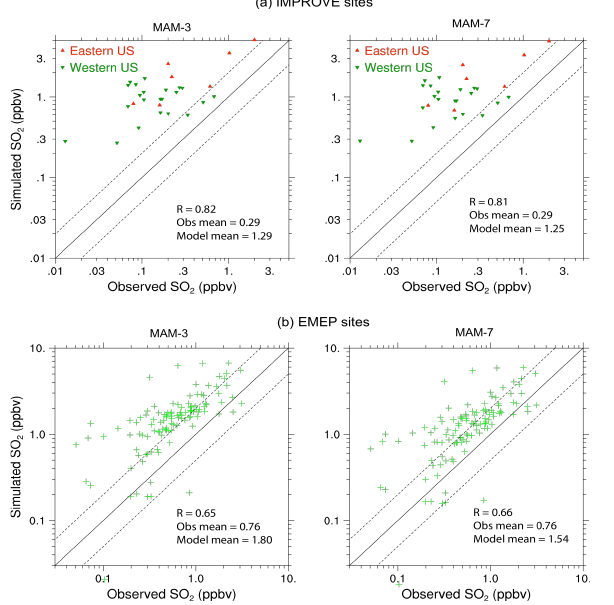
Figure 9. Observed and simulated annual-average sulfate (SO 4 ) concentrations at IMPROVE and EMEP network sites. Observations are for site-available years between 1995-2005. Simulated values for MAM3 (left) and MAM7 (right) are from model lowest layer. Top: IMPROVE network, Eastern U.S. sites are east of 97 W longitude. Bottom: EMEP network. EMEP plots show total and non-sea salt (nss) SO 4 , and IMPROVE plots show total SO 4 . The CAM5 SO 4 species are nss-SO 4 , and simulated total SO 4 includes a sea-salt component equal to 7.7% of the simulated sea salt concentration. The means and correlation coefficients (R) are for total SO 4 .